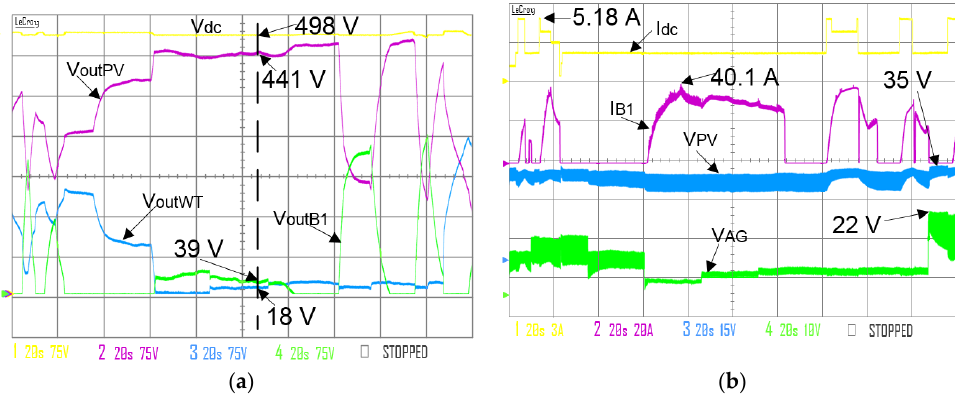
Figure 7. Experimental results: ( a ) DC converters’ output voltages and bus voltage V dc ; ( b ) I dc load current, battery current I B 1 , PV and TW voltages.